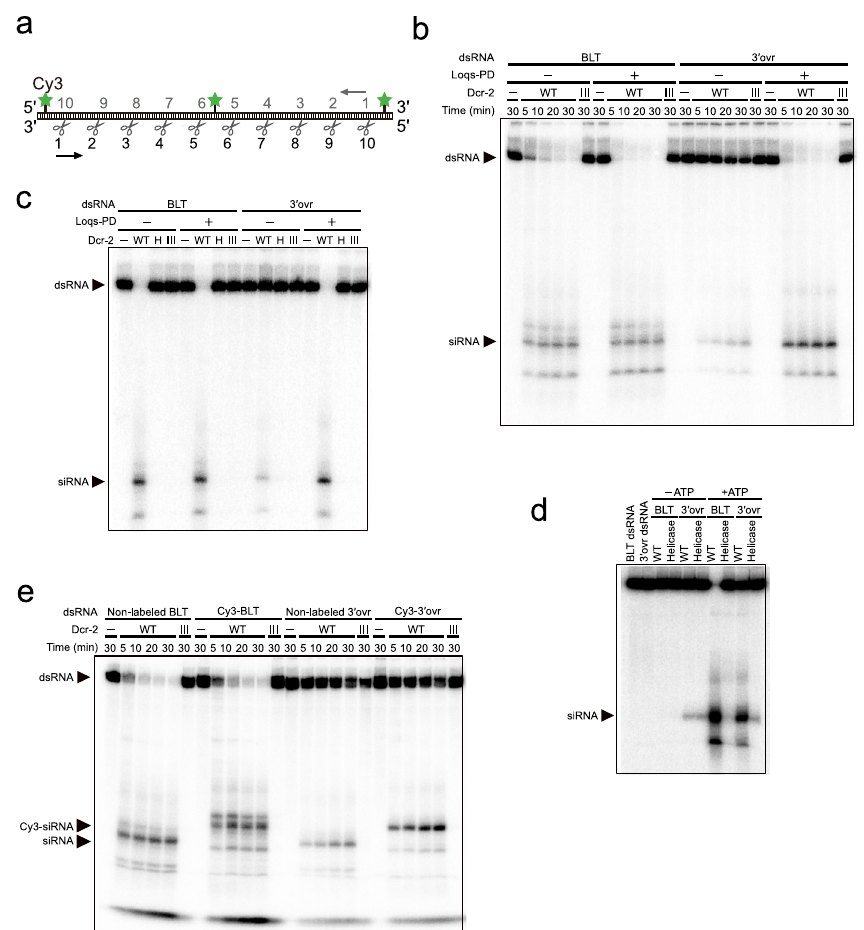
Fig. 1 Cy3 labeling of dsRNA does not affect Dcr-2 ’ s cleavage activity. a Schematic of the double-stranded RNA substrate labeled with 3× Cy3 at designated positions. Scissors represent cleavage sites. b dsRNA cleavage assay using wild-type Dcr-2 or the RNase III mutant (III) (~15 nM), BLT or 3 ′ ovr dsRNAs (5 nM), and ±Loqs-PD (50 nM). n = 3 independent experiments. c dsRNA cleavage assay for the helicase (H) and RNase III mutants. Enzyme and dsRNA concentrations were the same as in b and the incubation time was 10 min. n = 2 independent experiments. d dsRNA cleavage assay with a higher concentration of Dcr-2, using wild-type Dcr-2 or the helicase mutant (~30 nM), and BLT or 3 ′ ovr dsRNA (1 nM) with or without ATP. The incubation time was 120 min. n = 2 independent experiments. e dsRNA cleavage assay for the comparison between non-labeled and Cy3-labeled dsRNAs. In b – e one strand of dsRNAs was radiolabeled at the 5 ʹ end and detected by phosphor imaging (see “ Methods ” section). n = 3 independent experiments. Source data are provided as a Source Data fi